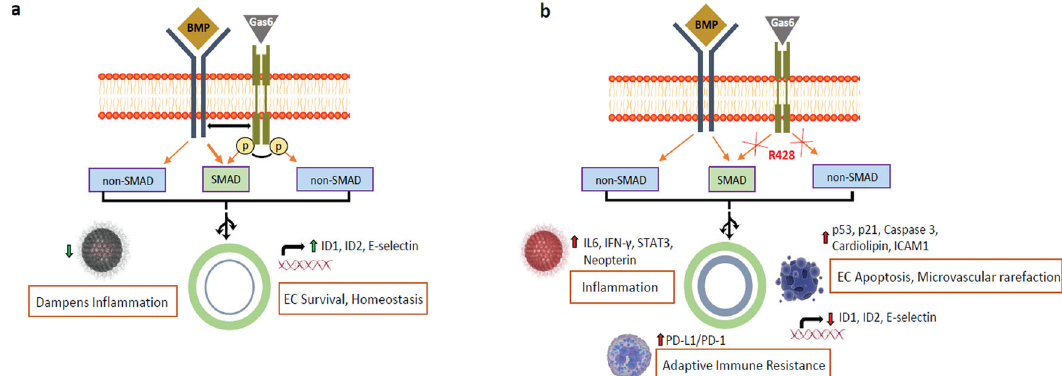
Fig. 10 Proposed model of the effect of R428 on bone morphogenetic protein receptor (BMPR) 2 signaling and multiple facets of the inhibition of Gas6/Axl signaling in PAH. a BMP signaling and EC homeostasis are maintained by Axl signaling. Gas6/Axl guards the anti-in fl ammatory response, EC survival and homeostasis by augmentation of BMPR2-related canonical SMAD. b The inhibition of Axl by R428 leads to the inhibition of canonical BMP/ SMAD signaling, augmentation of in fl ammation, adaptive immune evasion, EC apoptosis and microvascular rarefaction. ID1 = inhibitor of DNA binding 1; SMAD = mothers against decapentaplegic homolog 7; EC = endothelial cell; Gas6 = growth arrest-speci fi c 6; IL6 = Interleukin 6; IFN- γ - Interferon gamma; ICAM1 = Intercellular Adhesion Molecule 1; PD-1/PD-L1 = programmed death ligand-1/programmed cells, driven by BMPR2-related EC apoptosis (Fig. 10). Together, our results indicate that the systemic targeting of Axl in the context of PAH involves a number of potential pitfalls and may increase the risk of PH.